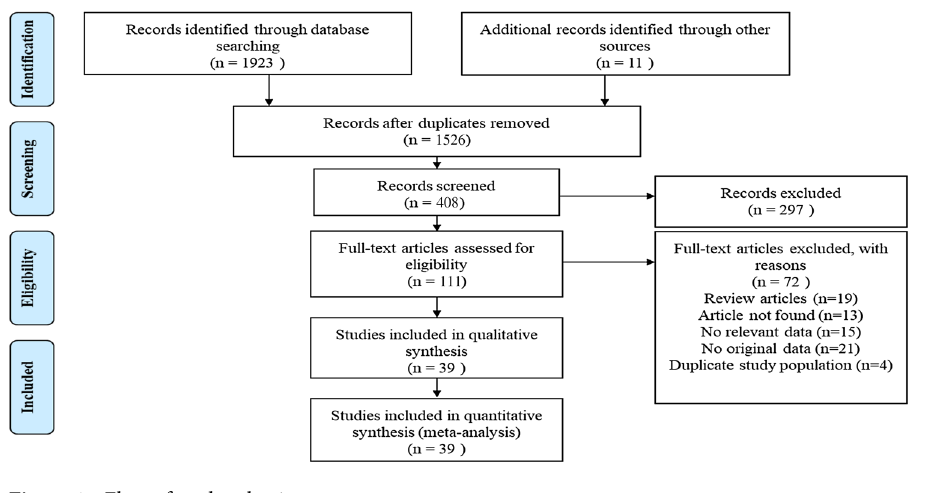
Figure 1. Flow of study